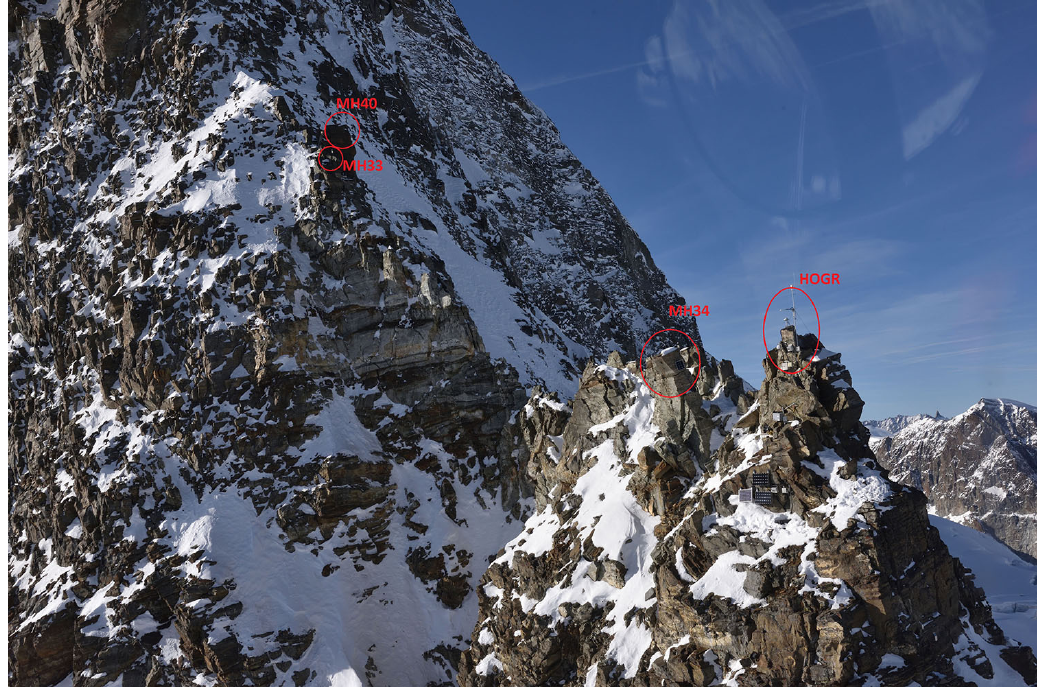
Figure C12. Closeup of the detachment zone (middle) and the buttress between the first and second couloirs. The instrument cluster around and below GNSS measurement position MH42/HOGR (right) contains the weather station, webcam, high-resolution camera and sensor network base